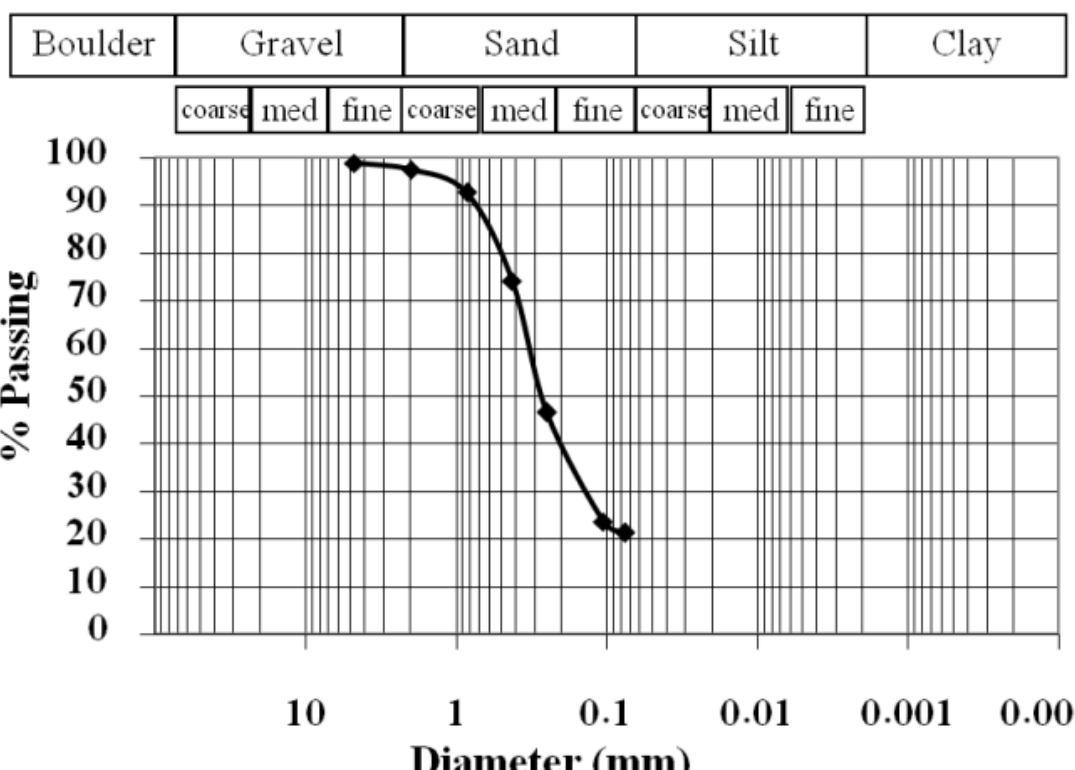
Figure 12. The sieve analysis of specimen 6 at 68.5E km at El-ferdan